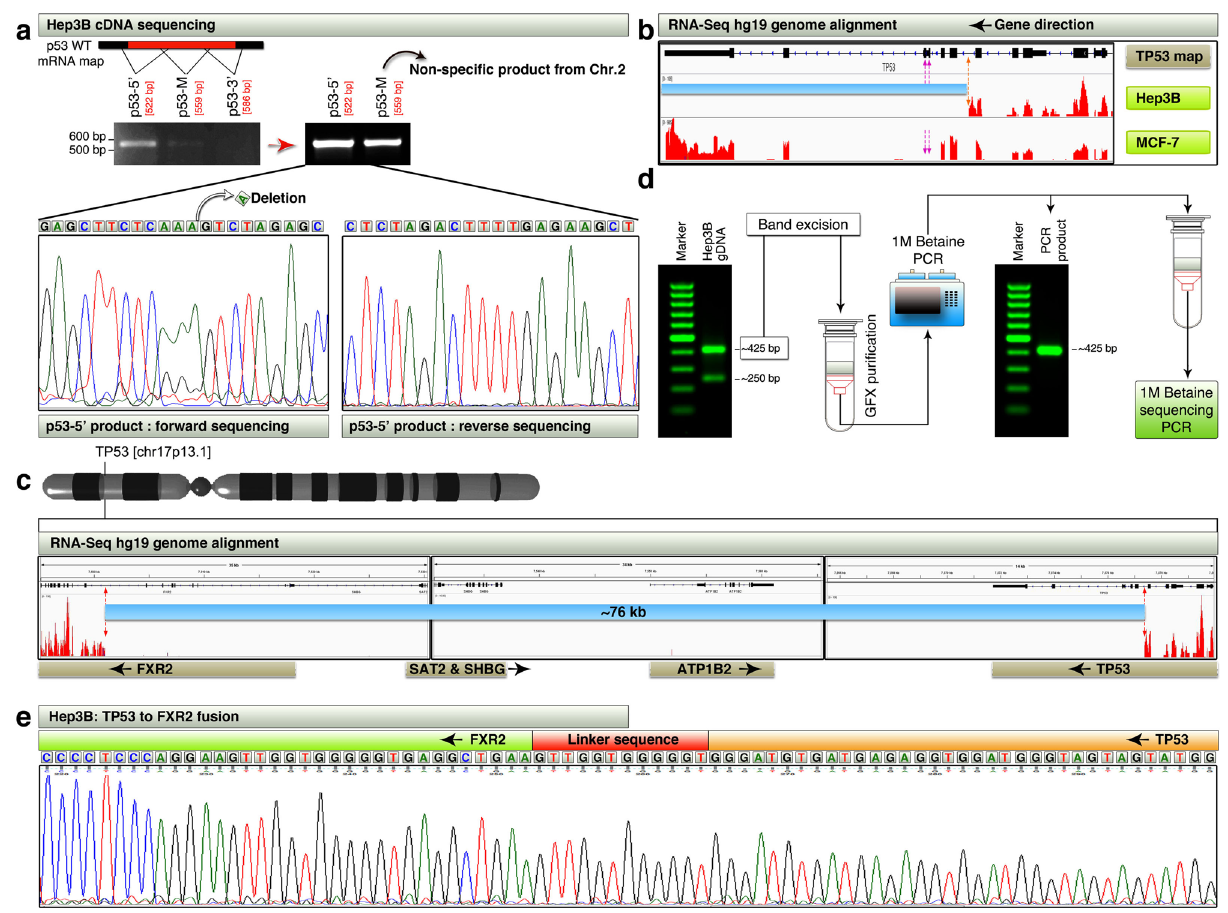
Figure 3. Hep3B cells express defective p53 mRNA and harbor TP53-FXR2 fusion as a result of 76 kb focal deletion. ( a ) RT-PCR and Sanger sequencing of p53 mRNA from Hep3B cDNA showing amplicons for 5’-end, and middle piece but not for 3’-end. The bands from left panel was re-amplified after GFX purification and shown on right panel. The p53-M turned out as a non-specific amplicon. Note the deletion of adenine in forward sequencing. ( b ) RNA-seq read mapping of Hep3B and MCF-7 cells to HG19 is visualized using IGV. Red dotted arrows in Hep3B show the potential deletion point and the blue bar shows the region of deletion (See panels c-e for more details). Purple dotted arrows show the exon skipping in MCF-7 cells. ( c ) Hep3B RNA-seq read mapping to HG19 showing lack of reads in 76 kb region from TP53 intron to FXR2 intron. Red dotted arrows show the potential deletion points within TP53 and FXR2 genes, and the blue bar shows the region of 76 kb deletion (See text for co-ordinate details). 3D chromosome-17 was created using Lightwave-3D (https:// www. newtek. com/ light wave/) v11.6.3. ( d ) Amplification of potential TP53-FXR2 fusion product from Hep3B gDNA (Left gel panel) by PCR. GFX purification and re-amplification of single 425 bp amplicon (right gel panel), before subjecting the product for Sanger sequencing. ( e ) Sanger sequencing to confirm the TP53- FXR2 fusion in Hep3B cells. This fusion is also expressed at mRNA level (Data not shown). Note-1: the linker sequence may be introduced during the focal deletion and fusion process. Note-2: 1 M final conc. betaine is required to sequence this fragment as several attempts without betaine was failed to get clean Wild-type and mutant p53s promote miR-520G and MAGEA expression. Given the strong clini- cal association of p53TI tumors with C19MC overexpression and presence of TP53-FXR2 fusion in Hep3B cells, we sought to examine the effect of wild-type and mutant p53s in C19MC miRNA expression in Hep3B cells. DNA binding consensus of p53 usually harbors palindromic DNA binding sites of CDKN1A and GADD45 genes that represent genome-wide and most prominent p53-binding consensuses 27,28 . The CDKN1A p53 binding sequence has two palindrome boxes within it. P53 CDKN1A palindromic box-1 (p53 CP box-1) has an 8-nucleo- tide palindrome GCC CGG GC which encompasses the 6-nucleotide palindrome of CCC GGG (Fig. 4a). The p53 CP box-2 has two 6-nucleotide palindromes of ACA TGT , of which the second one is extended to a 10-nucleotide palindrome of CAA CAT GTTG (Fig. 4a). Both CP box-1 and CP box-2 palindromes are abundantly located within C19MC and its flanking regions (Fig. 4a). Similarly during DNA damage response p53 orchestrates tran- scription of a different set of genes using a GADD45 consensus 29 . This consensus also has two GADD45 pal- indromes (GP box) of which ACA TGT is similar to CDKN1A consensus. The second GADD45 palindrome is GCA TGC and which can be extended to 8-nucleotide palindrome of AGC ATG CT (Fig. 4b). While the GP box